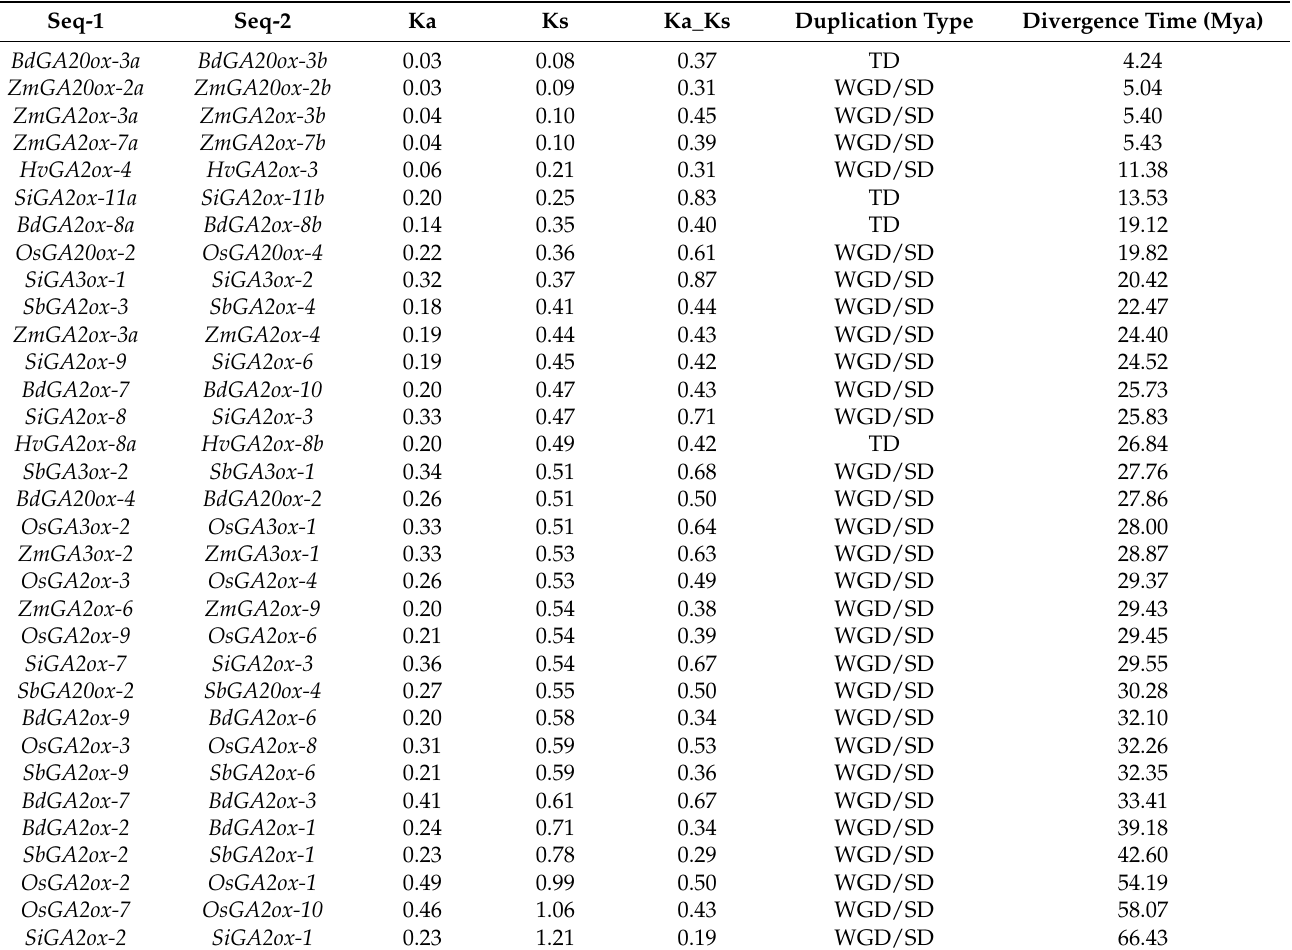
Table 1. Ka/Ks values and the divergence times of duplicate gene pairs in six tested